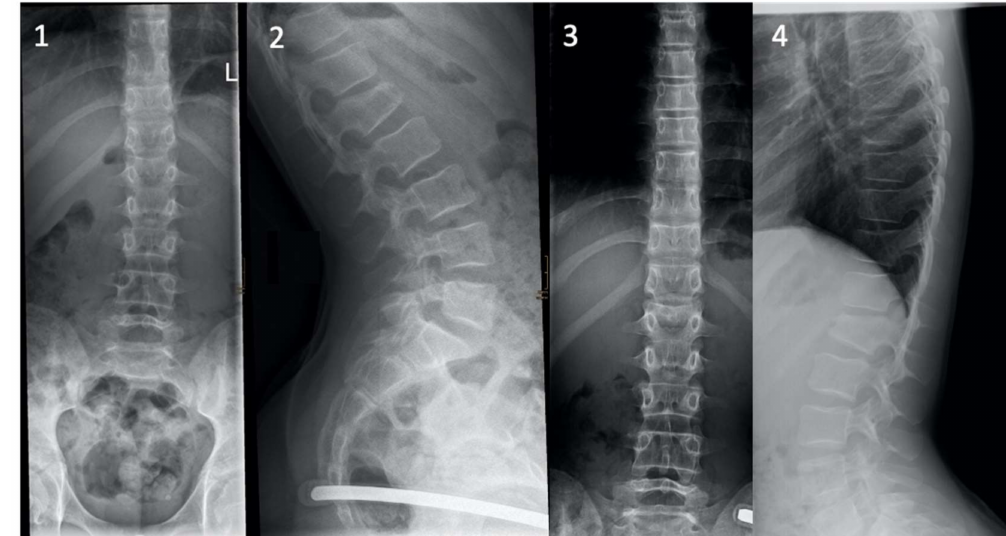
Figure 4. Images 1 and 2 show the radiographs of an A1.2 L1 fracture in a 12-year-old girl sustained after falling off a trampoline. The patient was treated conservatively by receiving adequate analgesia and sports abstinence. The radiographs at the last follow-up after three months of therapy show no further dynamics and a healed fracture (Images 3 and 4